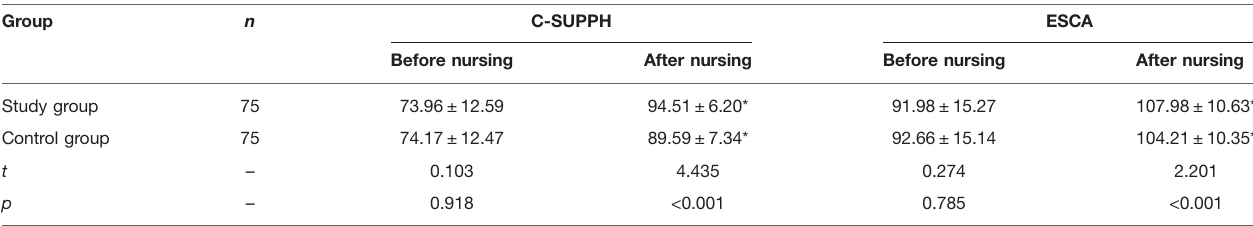
TABLE 1 | Comparison of C-SUPPH and ESCA scores between two groups of children before and after nursing ( (cid:1) x + s,